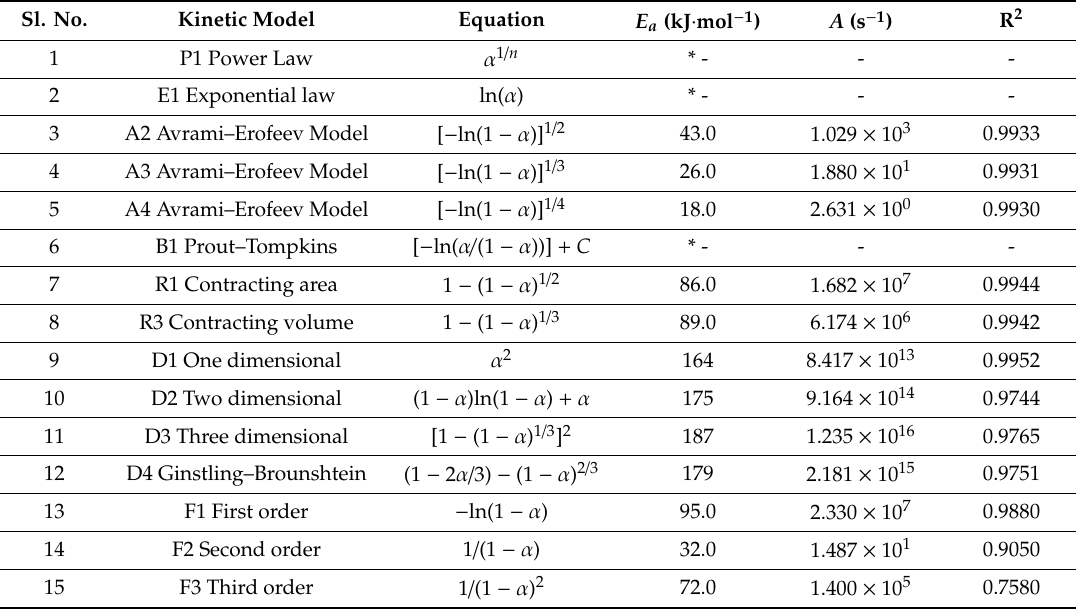
Table 3. Details regarding various outputs from the in-house method in the case of chitosan (as an